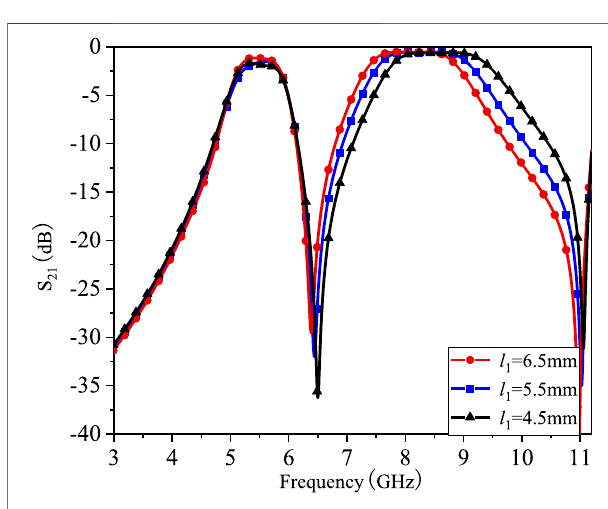
FIGURE 5 | Simulated S 21 of the fi lter against varied l 1